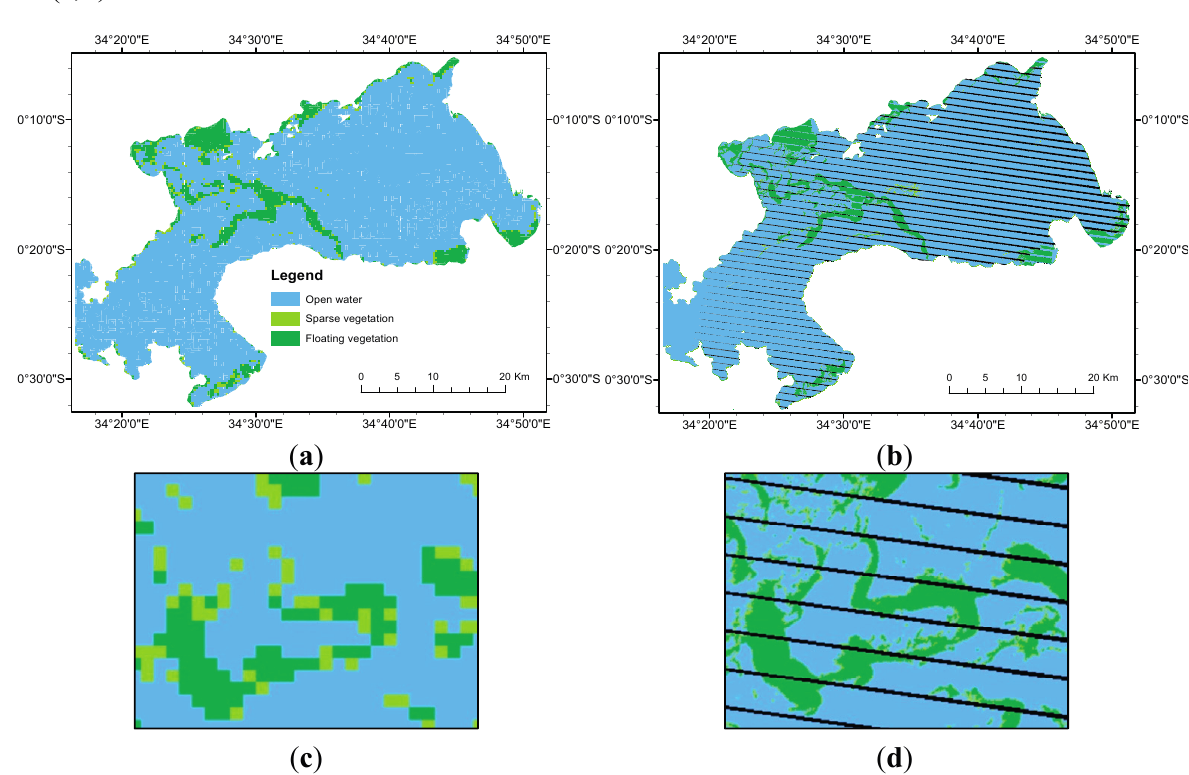
Figure 6. NDVI sliced to 3 levels: open water (OW), sparse vegetation (SV) and floating vegetation (FV), showing the distribution of vegetation as derived from ( a , b ) MERIS and ( c , d ) ETM+.